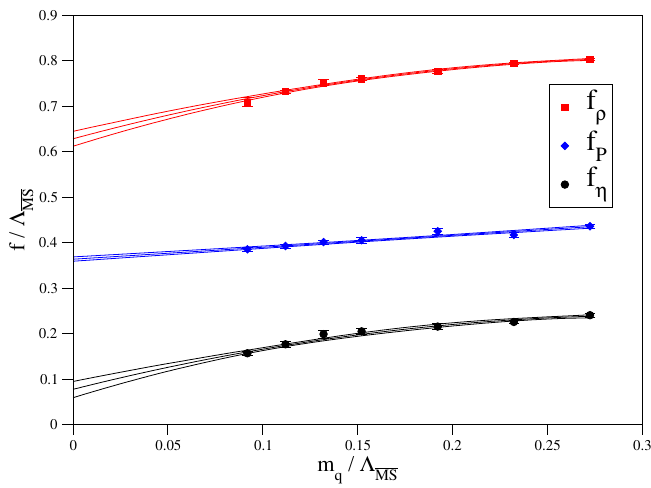
Figure 3 . The quantities f (cid:17) , f (cid:26) , and f P for our lightest masses. With the (cid:12)ts used to determine their results in the massless limit.